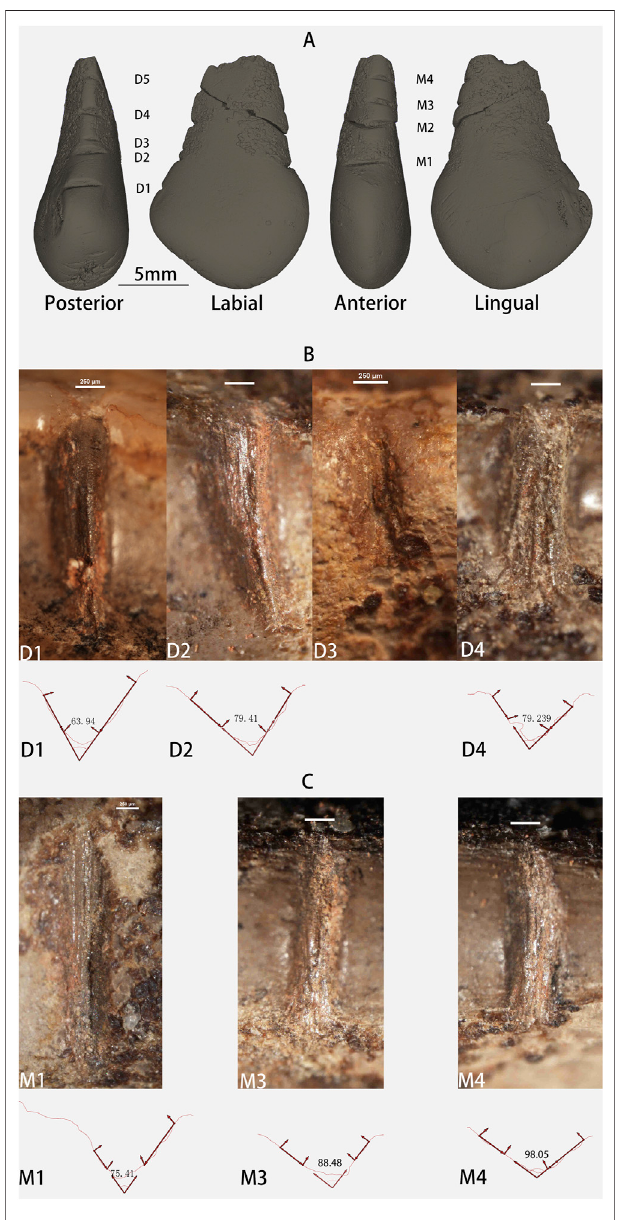
FIGURE 5 | (A) Location of the notches on the QG10 perforated tooth; (B) Notches on the posterior aspect and their cross-sections with measured angles ( ˚ ); (C) Notches on the anterior aspect and their cross-sections with measured angles ( ˚ ). Scales: (A) 5 mm, (B,C) 250 μ m.